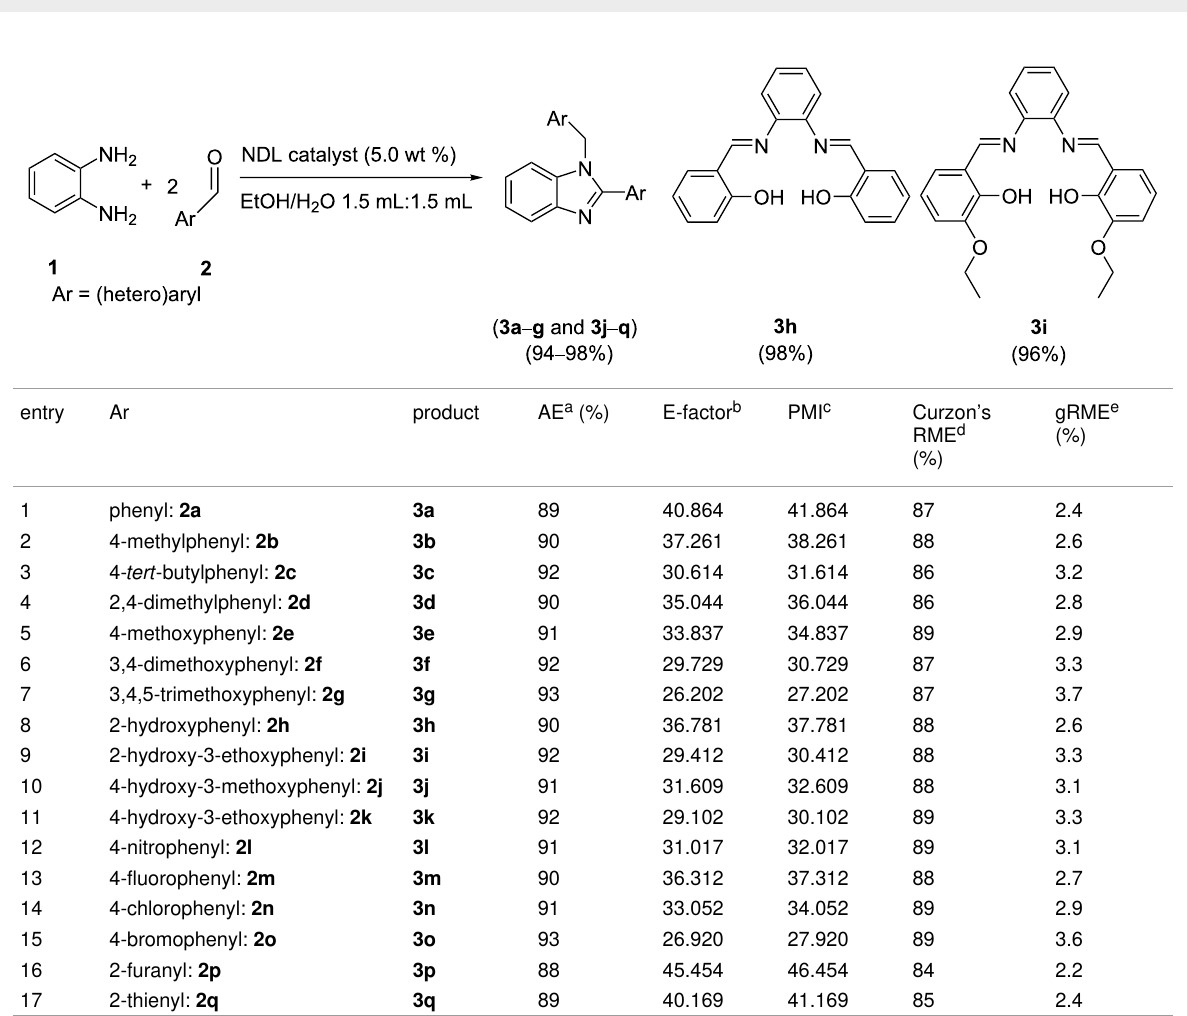
Table 8: Green chemistry metrics for the synthesis of 2-aryl-1-arylmethyl-1 H -benzo[ d ]imidazoles 3 .